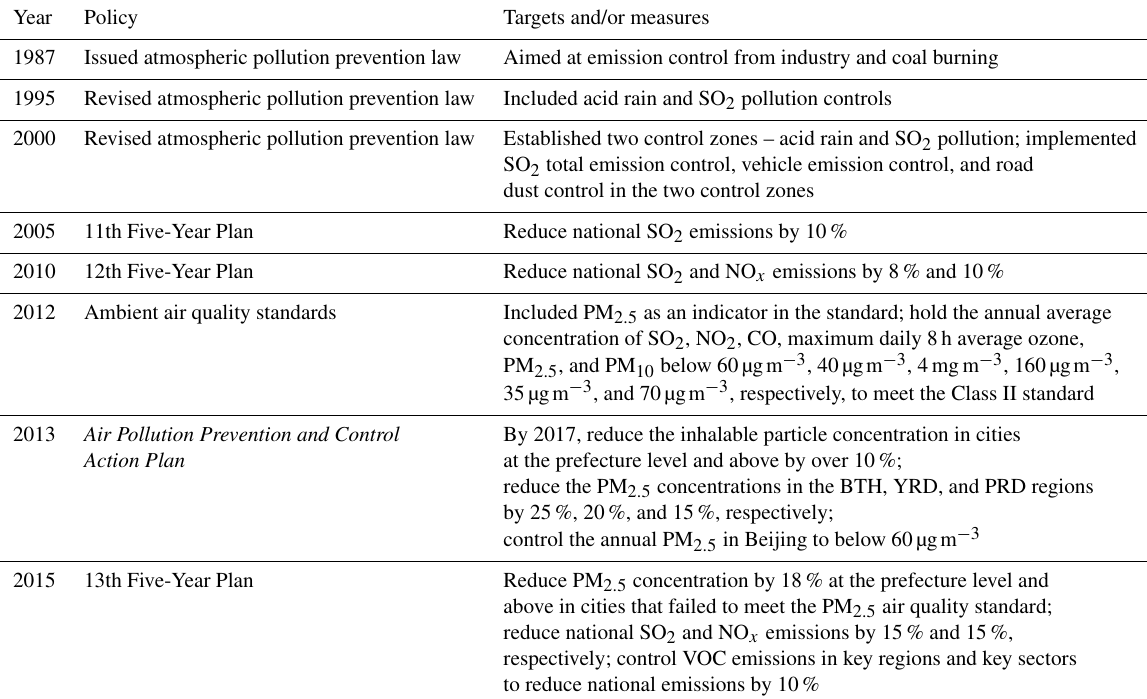
Table 1. Milestones of major air quality regulations in China over the past decades. BTH is Beijing–Tianjin–Hebei; YRD is Yangtze River Delta; PRD is Pearl River